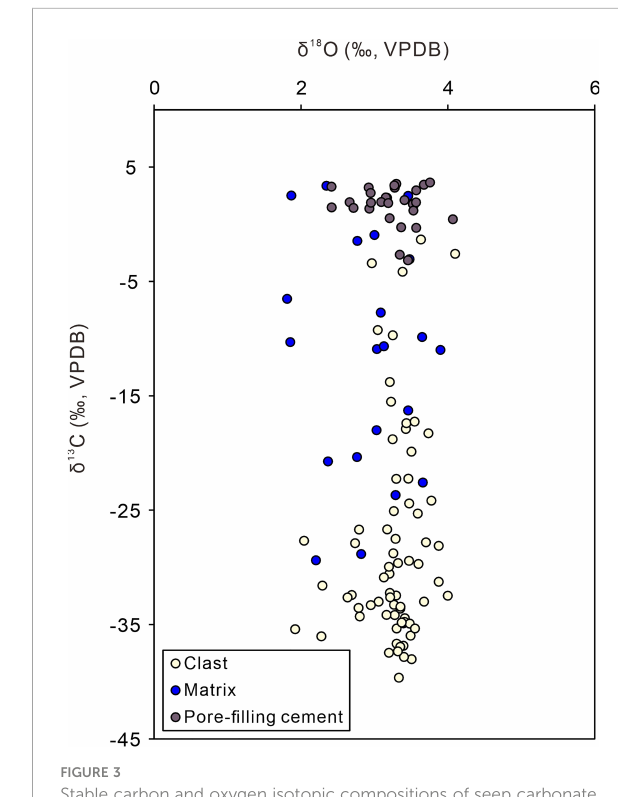
FIGURE 3 Stable carbon and oxygen isotopic compositions of seep